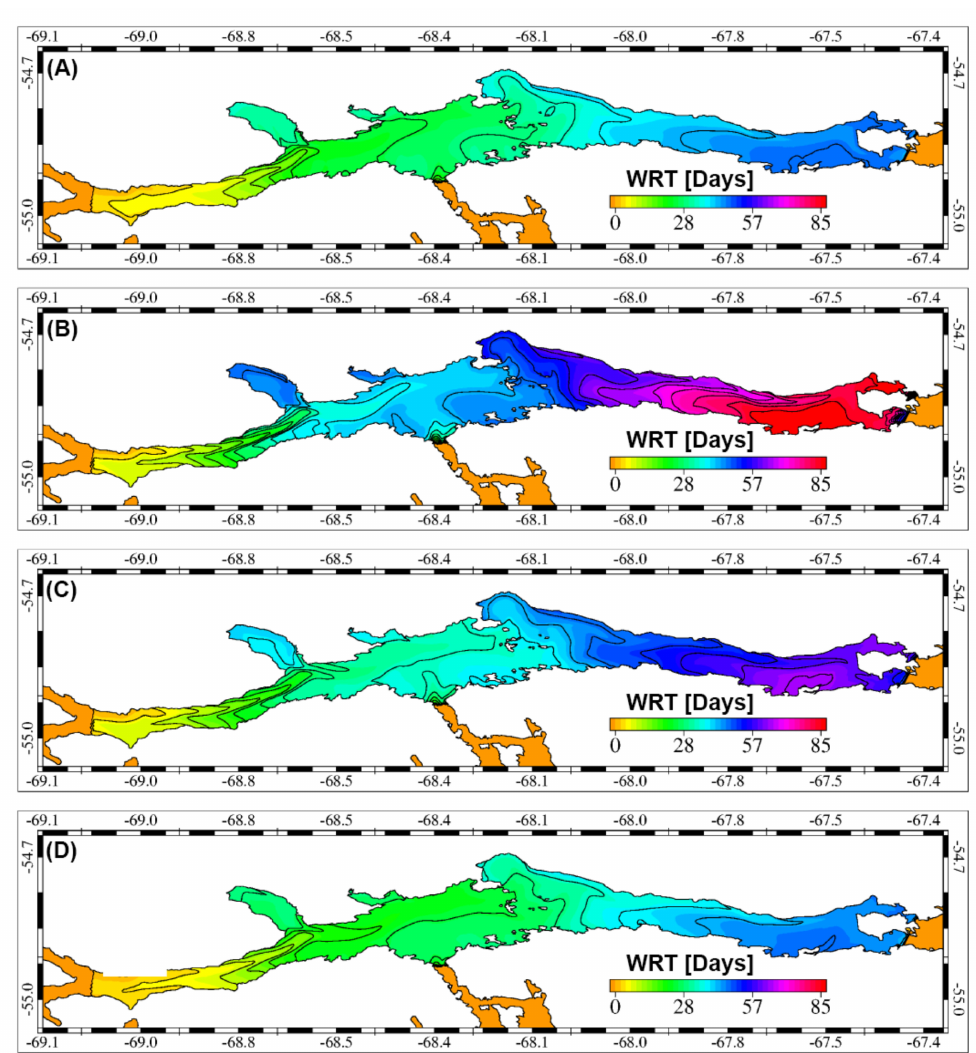
Figure 8. Seasonal water residence times computed for surface layers. From top to bottom, summer ( A ), autumn ( B ), winter ( C ), spring ( D